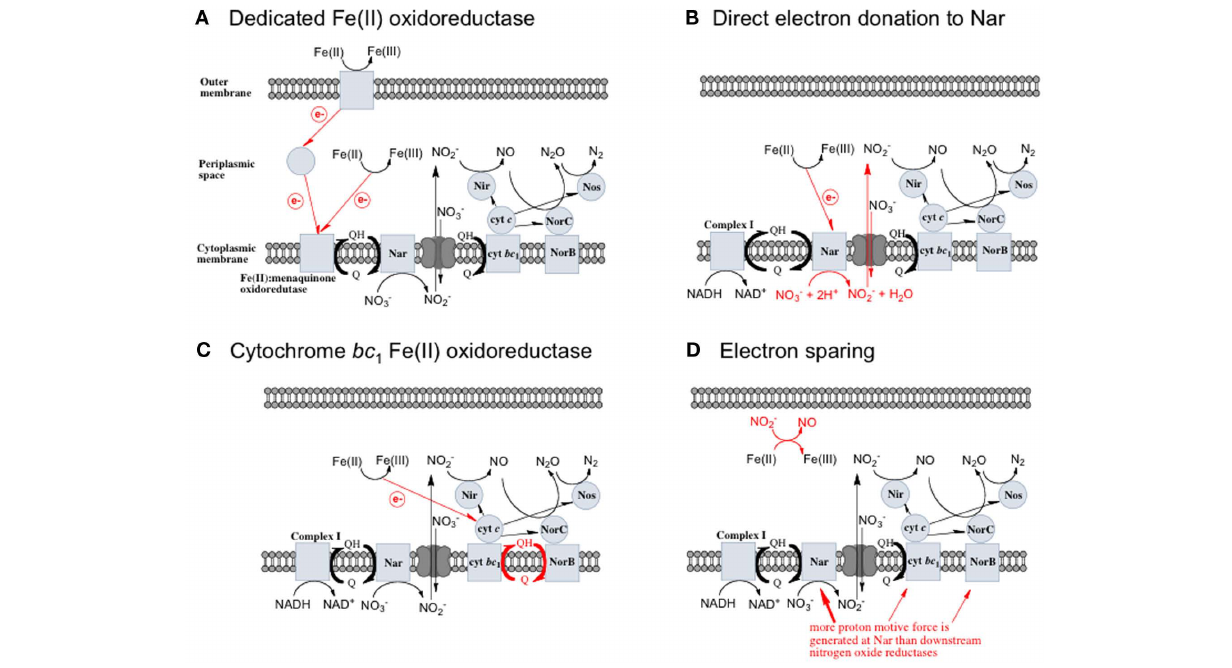
FIGURE 1 | Possible mechanisms for energetic benefit from iron oxidation coupled to nitrate reduction. (A) A true Fe(II):menaquinone oxidoreductase accepts electrons from iron and reduces the quinone pool, (B) Nar accepts electrons from Fe(II) and reduces nitrate cytoplasmically, consuming protons to generate a PMF, (C) the cytochrome bc 1 complex accepts electrons from Fe(II) and reduces the quinone pool, (D) more protons